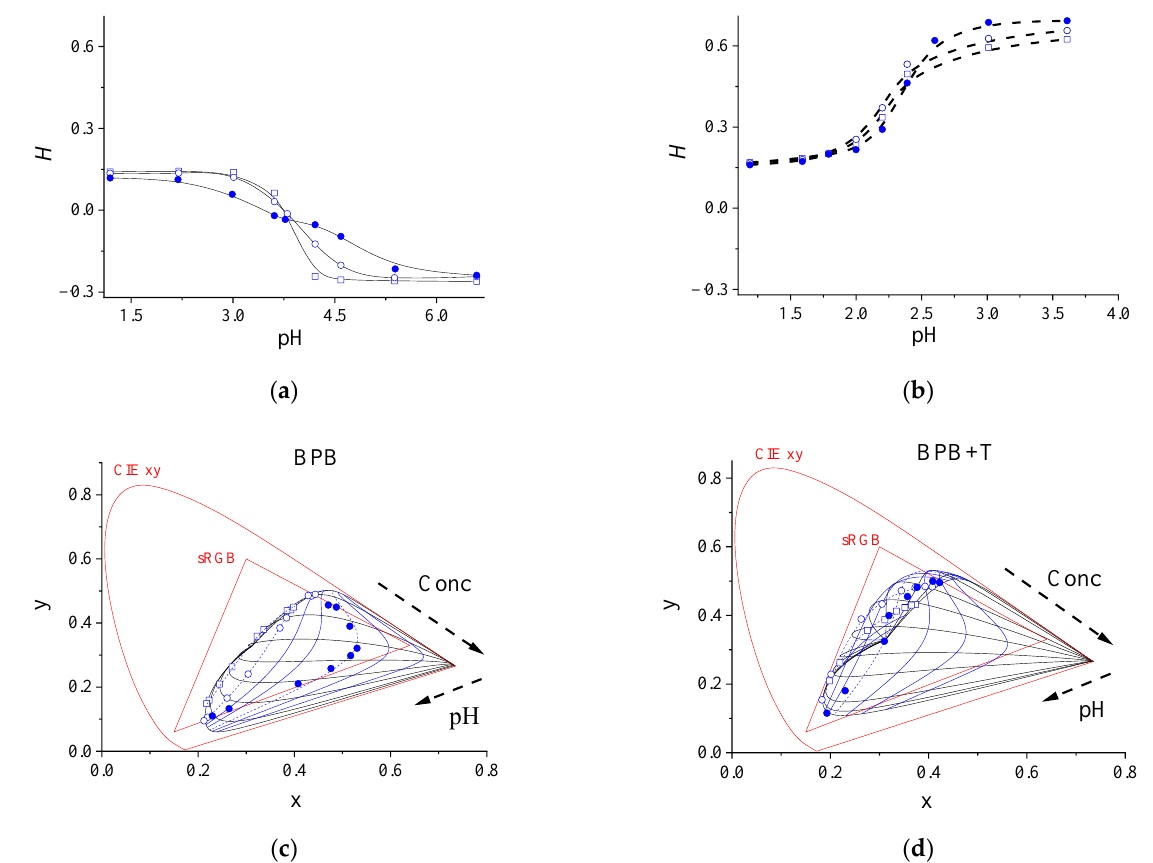
Figure 3. BPB calibration curves H vs. pH without ( a ) and with T ( b ). Symbols and lines are the experimental (solutions of Figure 2) and the simulated data, respectively. pH values: 1.19, 2.20, 3.01, 3.61, 3.80, 4.21, 4.59, 5.38, 6.59 in ( a ) and 1.19, 1.59, 1.79, 2.00, 2.20, 2.39, 3.01, 3.61 in ( b ). 𝑙𝑜𝑔𝐶 𝐼 ∙ 𝑝 = −4.54 (□), −4 .24 ( ○ ), −3 .91 ( ● ). ( c ) and ( d ) same data as ( a ) and ( b ) located in the CIE-xy and s-RGB color-spaces domains. The arrows indicate the direction of the BPB concentration and pH changes.